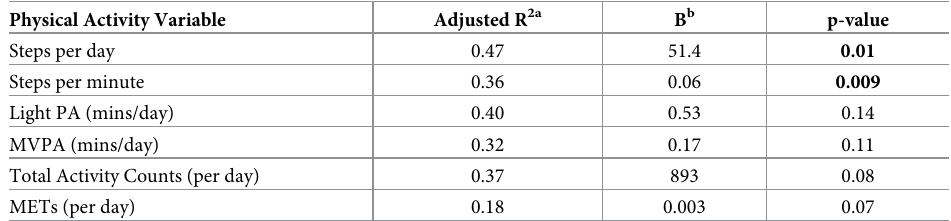
Table 2. Associations between total Walk Score and physical activity measures. Physical Activity